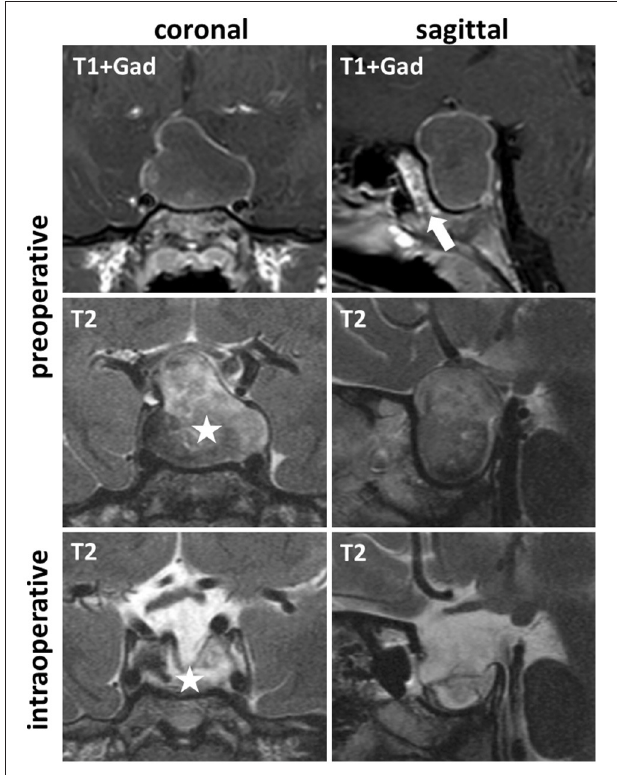
FIGURE 1 | Pre- and intraoperative MRI; T1-weighted MR images after gadolinium contrast medium application (T1 + Gad) and T2-weighted MRI showed in coronal and sagittal orientation a preoperative intra and suprasellar cystic tumor, lacking sphenoid sinus pneumatization (T1 + Gad, sagittal, arrow). Intraoperative imaging confirmed complete drainage of the cyst (T2 coronal,